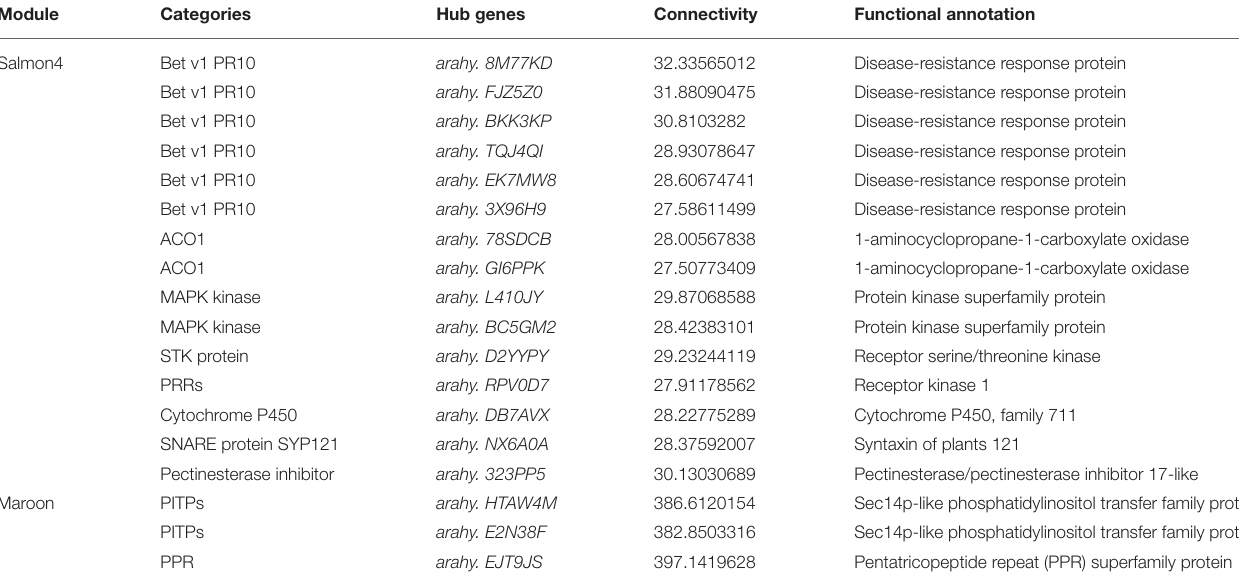
TABLE 1 | Hub genes involved in resistance to A. flavus